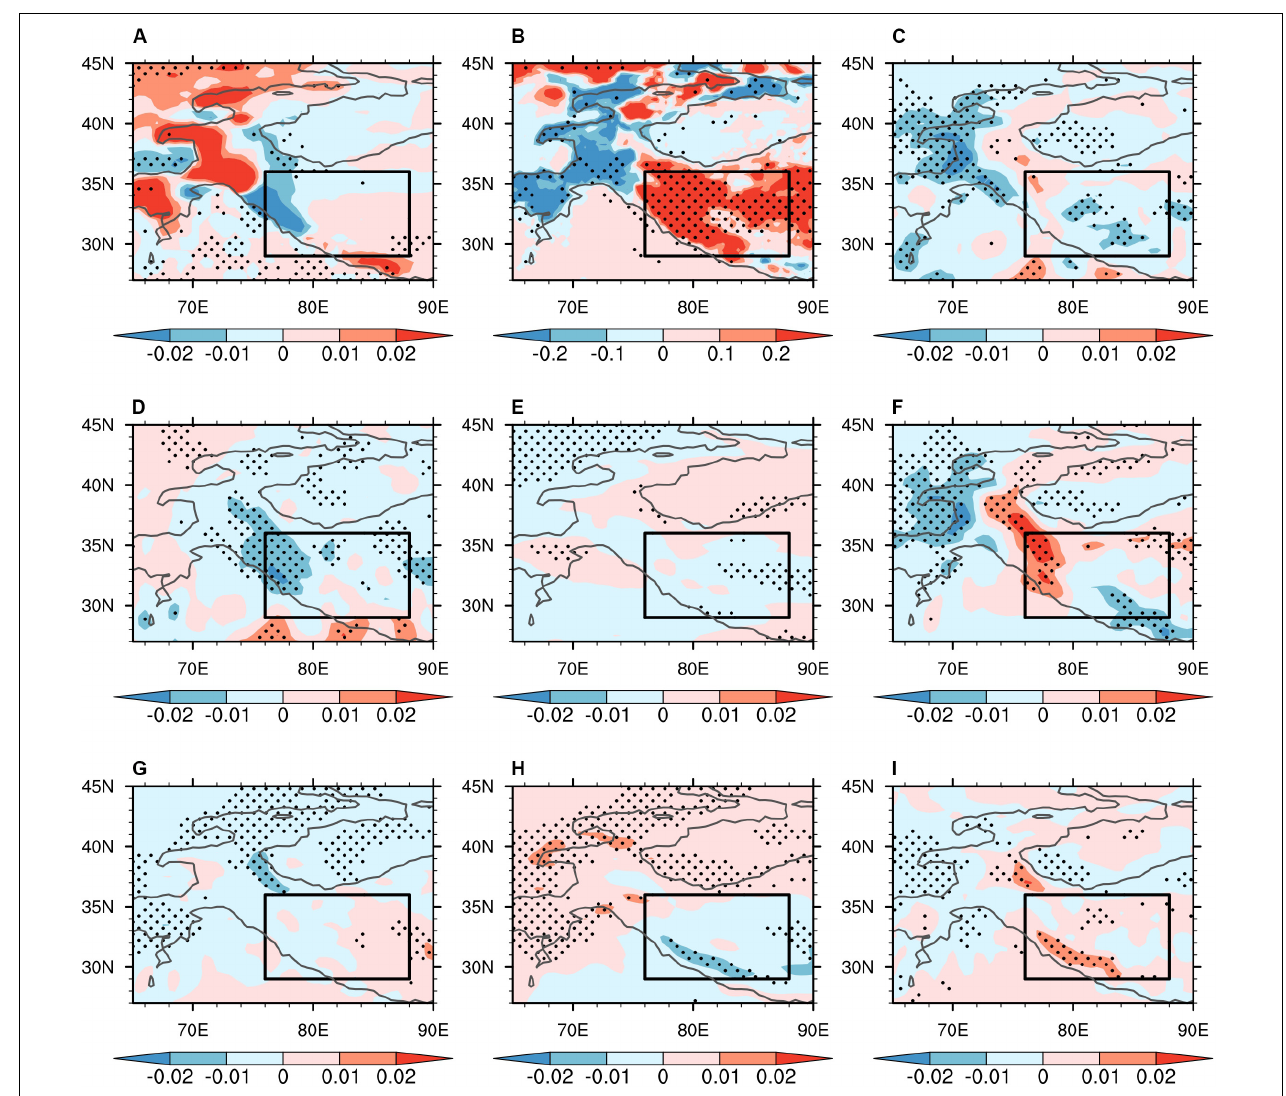
FIGURE 8 | Regression fields of (A) the winter snowfall (units: mm/day), (B) snow depth (units: cm), and (C) the moisture divergence D at 400 hPa (units: 10 − 8 g/cm 2 • s • hPa); and the (D) zonal advection, (E) meridional advection, (F) vertical advection, (G) zonal convergence, (H) meridional convergence, and (I) vertical convergence (units: 10 − 8 g/cm 2 • s • hPa) of moisture flux at 400 hPa, against the BSICI. The stippled areas exceed the p = 0.1 confidence level. The black box (29 ◦ –36 ◦ N, 76 ◦ –88 ◦ E) represents the MWTP region. The gray line over the region (25 ◦ –45 ◦ N, 60 ◦ –110 ◦ E) outlines the 2-km topography of the Tibetan